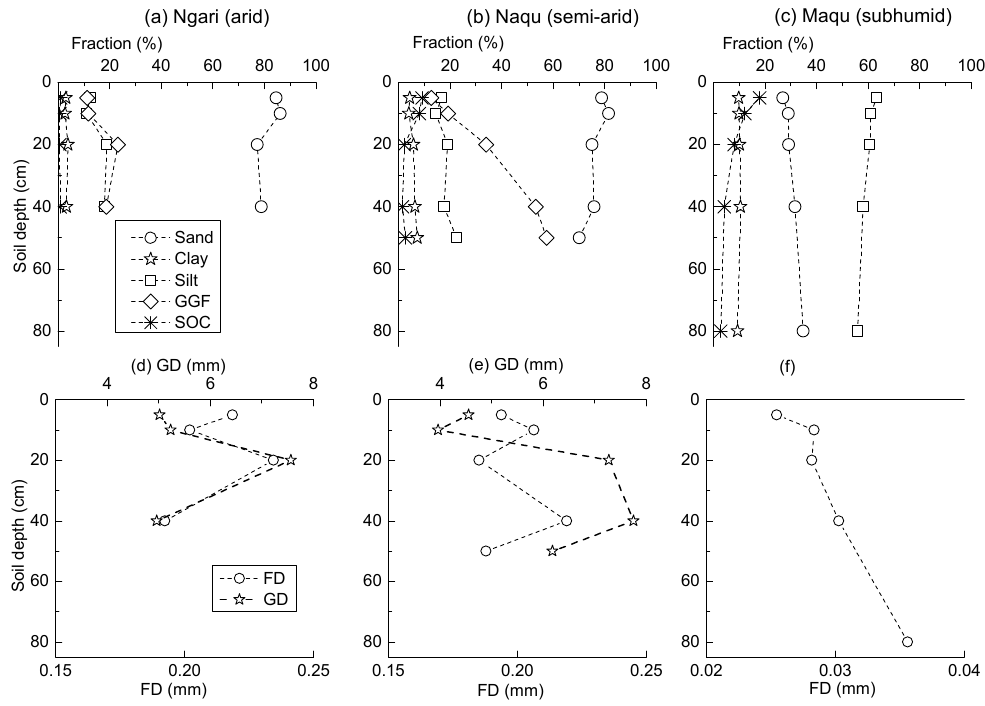
Figure 3. Profiles of mean soil basic properties at three climate zones. Top panel: variations in sand, clay, silt, GGF and SOC at various depths. Bottom panel: variations in GD and FD at different depths. GGF is the gravimetric gravel fraction. SOC is the soil organic matter content. FD is the mean particle diameter of fine minerals. GD is the mean particle diameter of